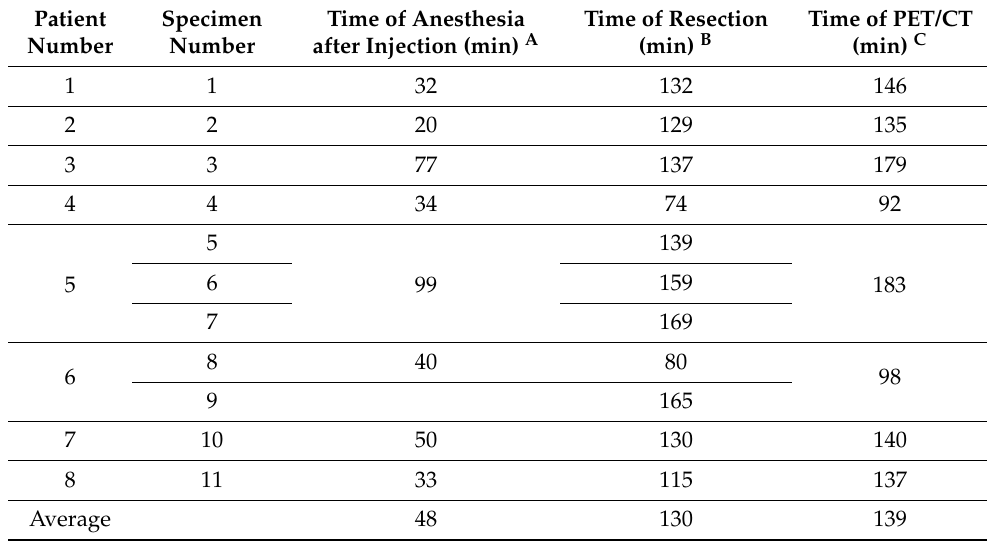
Table 2. Necessitated time from administration to intermediate